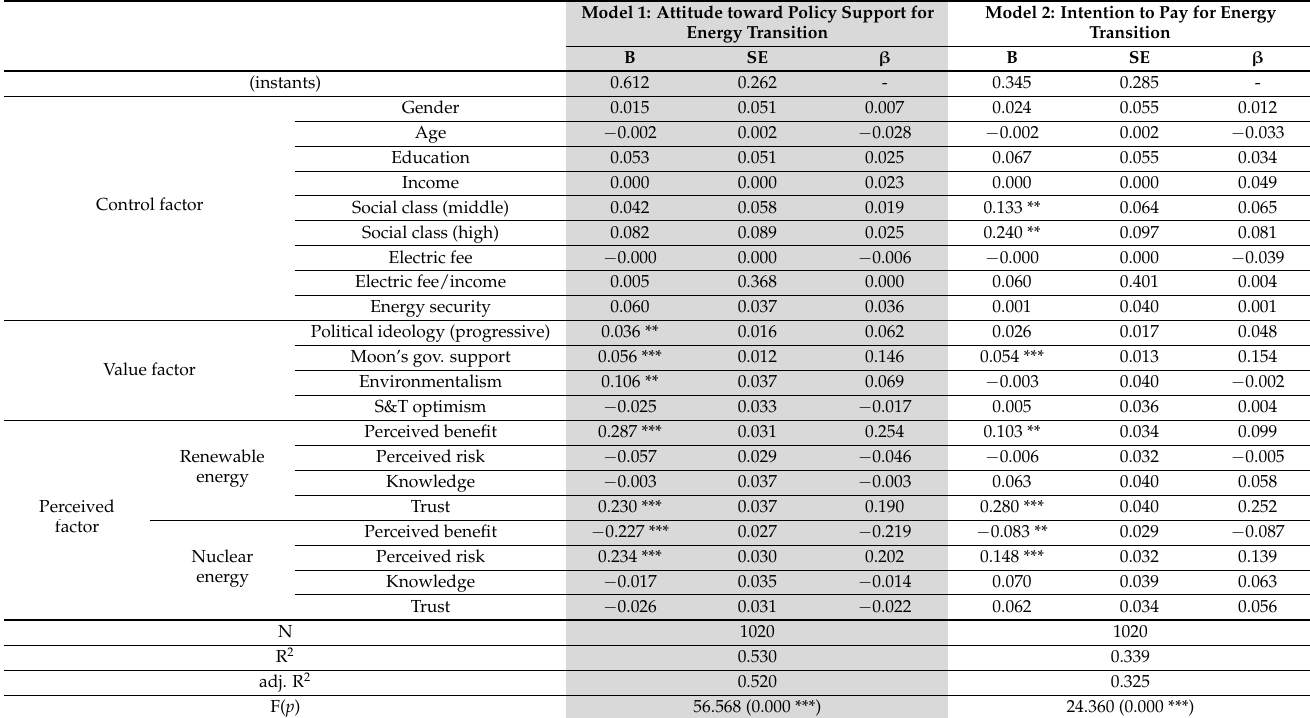
Table 3. Regression analysis.